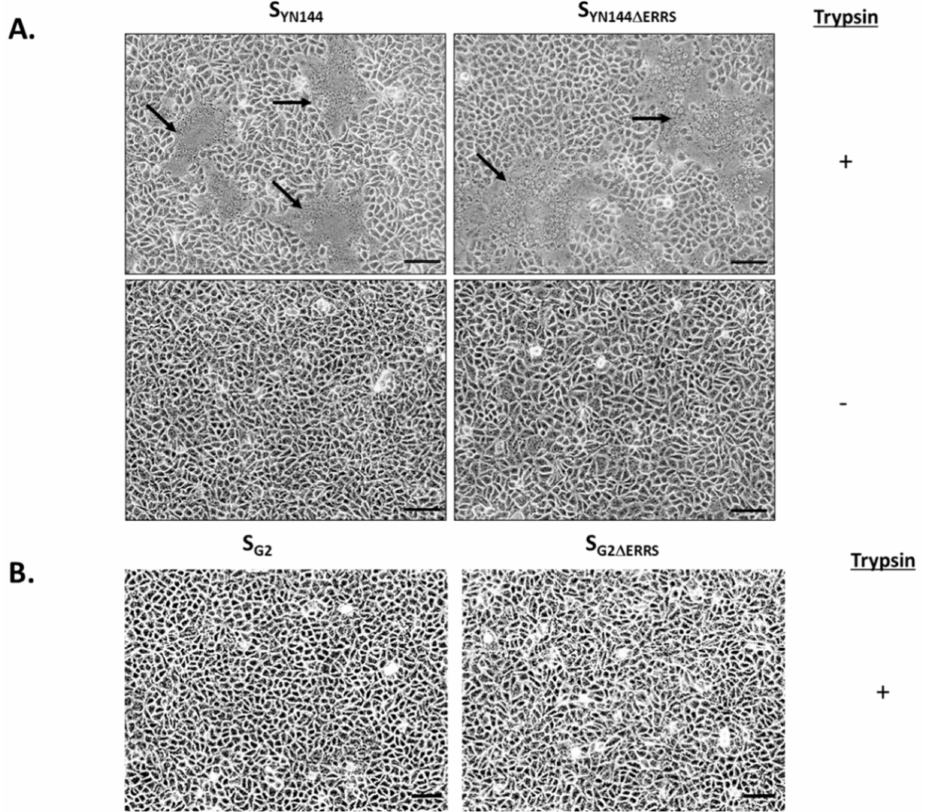
Figure 1. Formation of syncytia in VeroE6 cells stably expressing porcine aminopeptidase N (VeroE6-APN) expressing porcine epidemic diarrhea virus (PEDV) S derived from YN144 and G2. ( A ) VeroE6-APN cells were transfected with pCAGGS expressing S YN144 with or without the C-terminal motifs (S YN144 ∆ ERRS ). Cells were cultured in the presence or absence of trypsin (2 µ g/mL). Syncytium formation was evaluated under a light microscope at 24 h post transfection (hpt). Arrows denote syncytium formation. Scale 100 µ m. ( B ) VeroE6-APN cells were transfected with pCAGGS